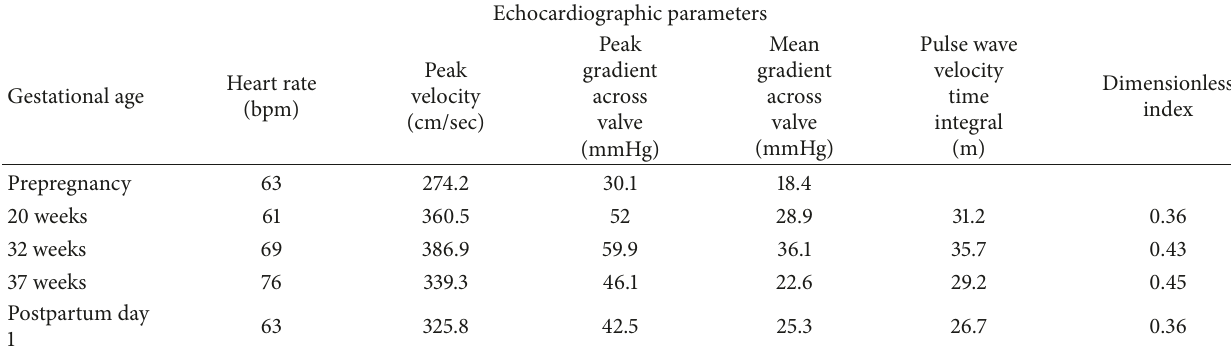
Table 1: Serial echocardiogram measurements through gestation.